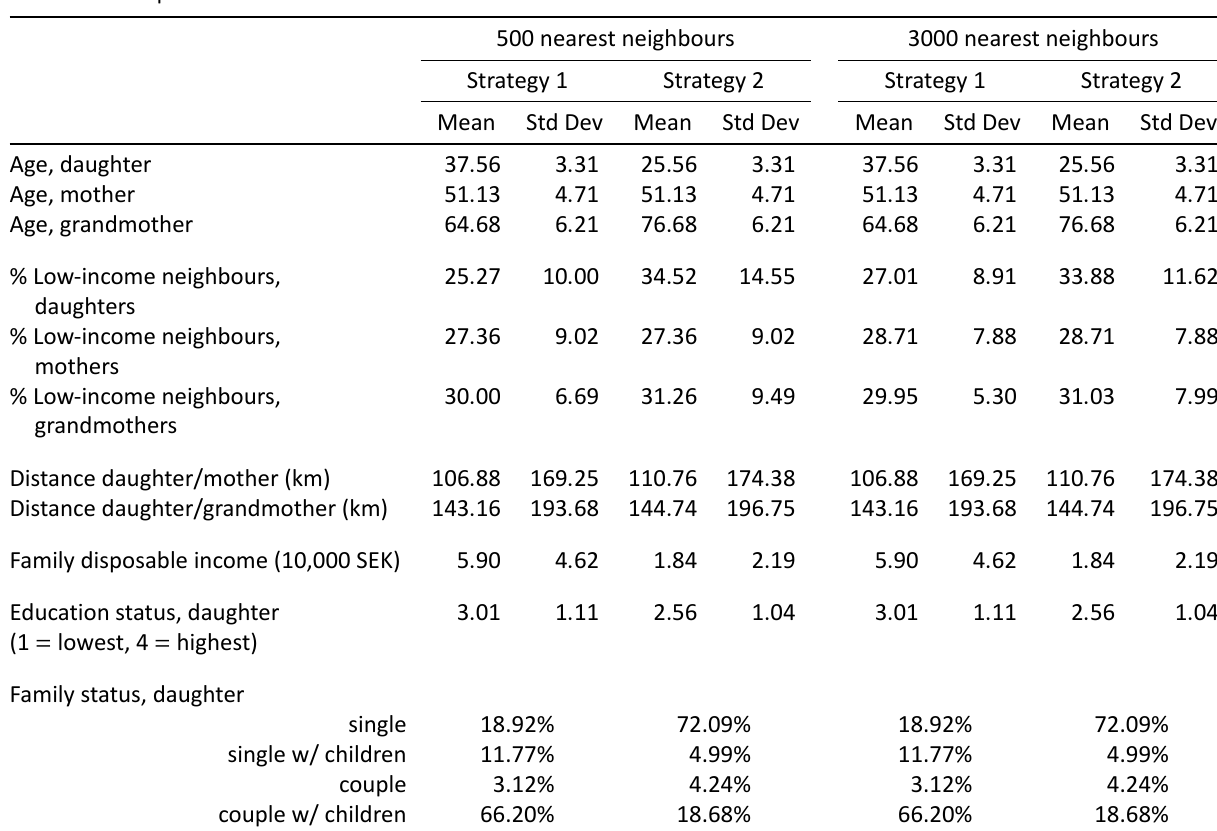
Table 1. Descriptive statistics.